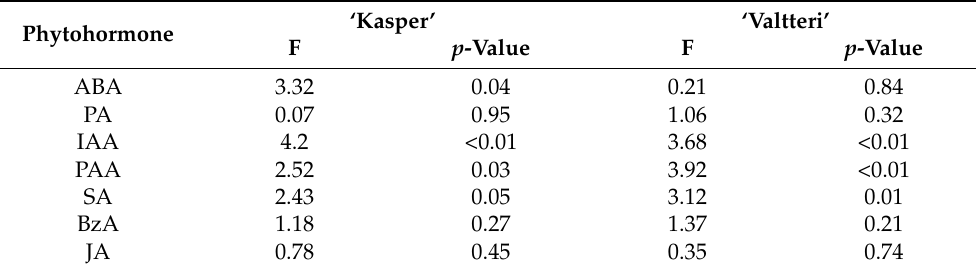
Table 5. Phytohormone concentrations were compared between Epichloë -symbiotic (E+) and Epich- loë -free (E-) plants (GLM) for both meadow fescue ( Festuca pratensis ) cultivars (‘Kasper’ and ‘Valtteri’). Significant p -values are highlighted in bold. The analyses covered the plant hormones abscisic acid (ABA), indole acetic acid (IAA), phenyl acetic acid (PAA), salicylic acid (SA), and jasmonic acid (JA), and a potential SA precursor benzoic acid (BzA), and the main product in ABA metabolism phaseic acid (PA).